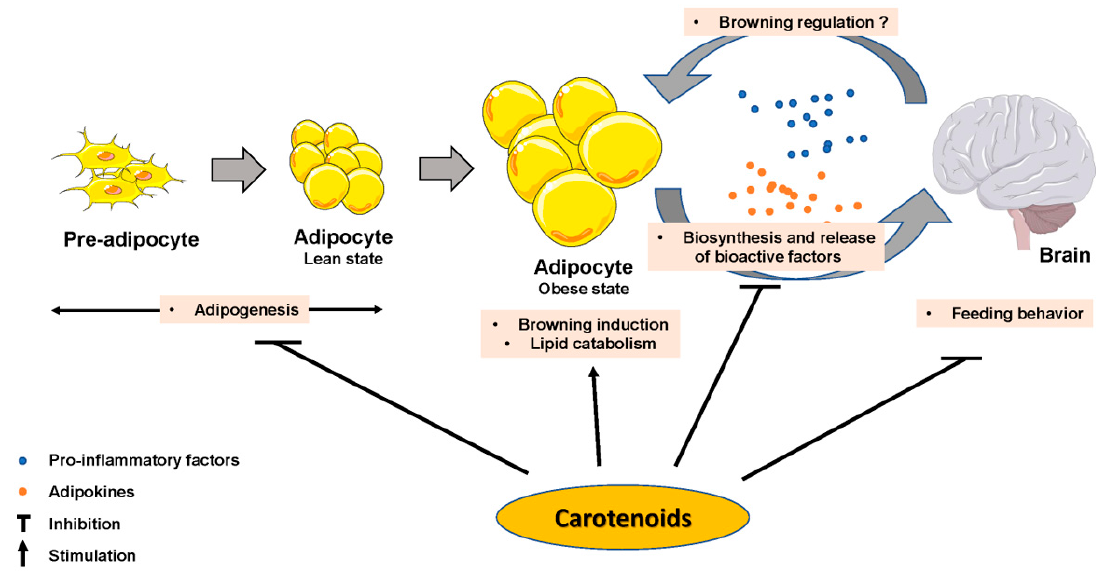
Figure 2. Carotenoids effect on adipose tissue biology parameters, on brain and on adipose tissue–brain crosstalk.